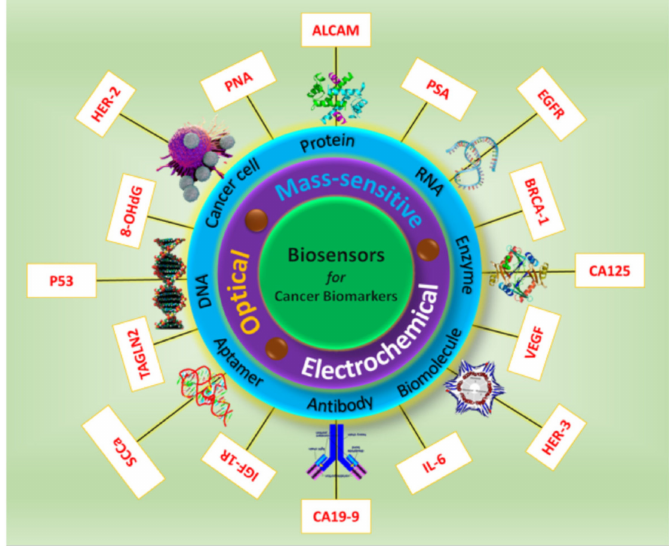
Figure 13. Schematic of biosensors’ working principle for cancer biomarkers’ detection (reprinted from Ref. no. [140], copyright 2021,